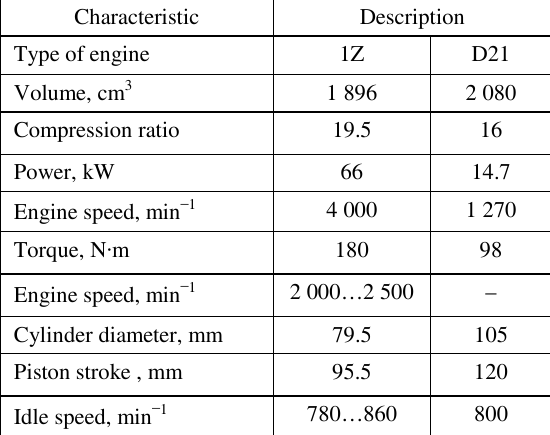
Table 1. Technical characteristics of the tested engines